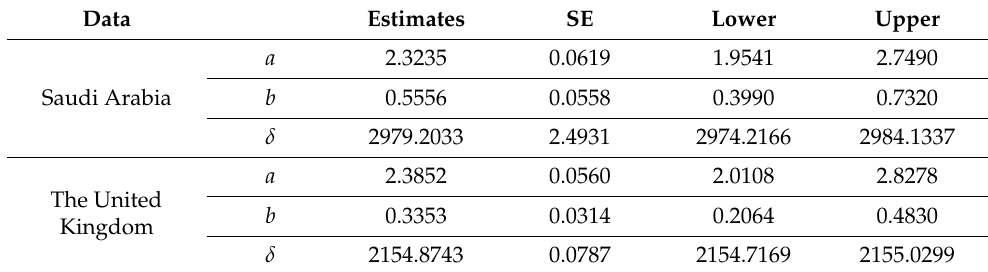
Table 9. Bayesian estimation based on SELF for parameters of UPBXD.